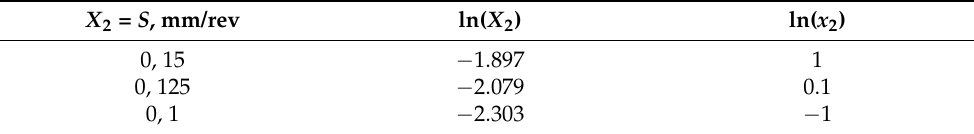
Table 3. Encoded values of feed S .